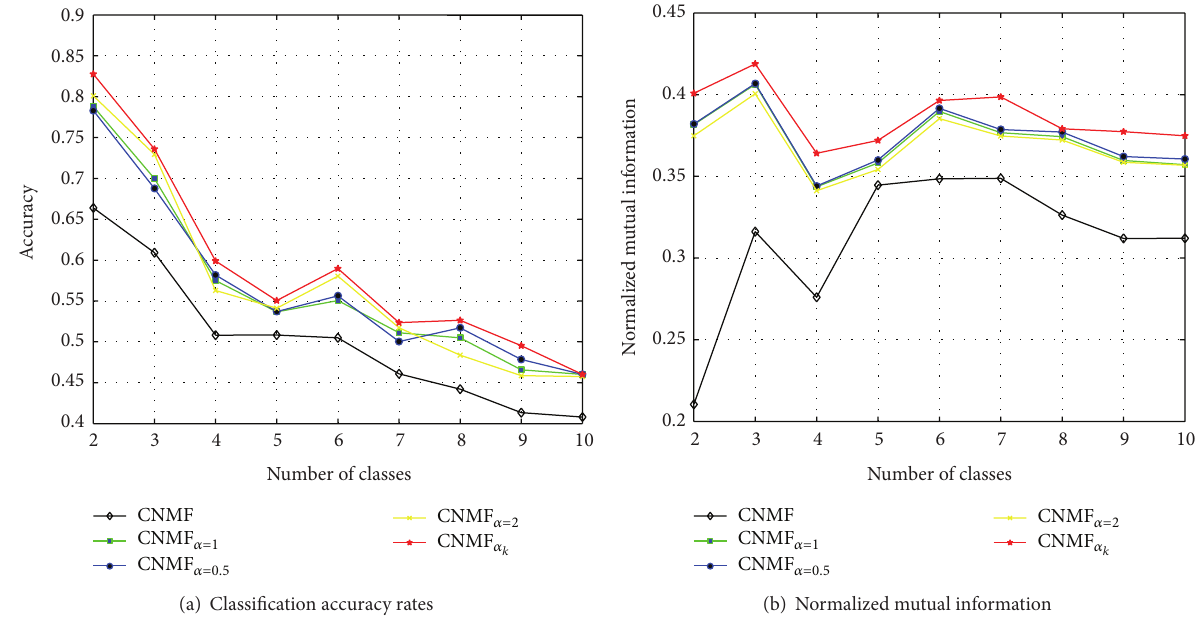
Figure 4: Classification performance on the Caltech 101 Database.